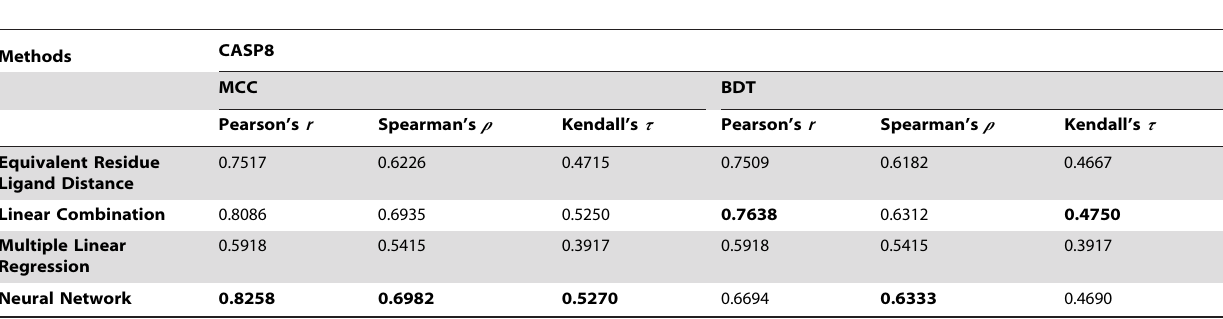
Table 1. Target-by-target analysis of the correlations for the top single feature score and each combination method (CASP8 data).